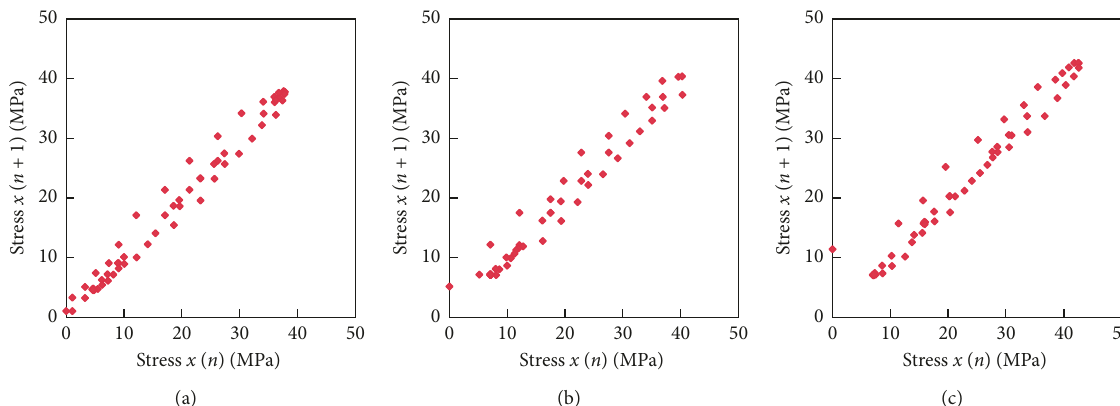
Figure 11: Evolution of each fitted stress series. (a) Fitted result of Group 1. (b) Fitted result of Group 2. (c) Fitted result of Group 3.